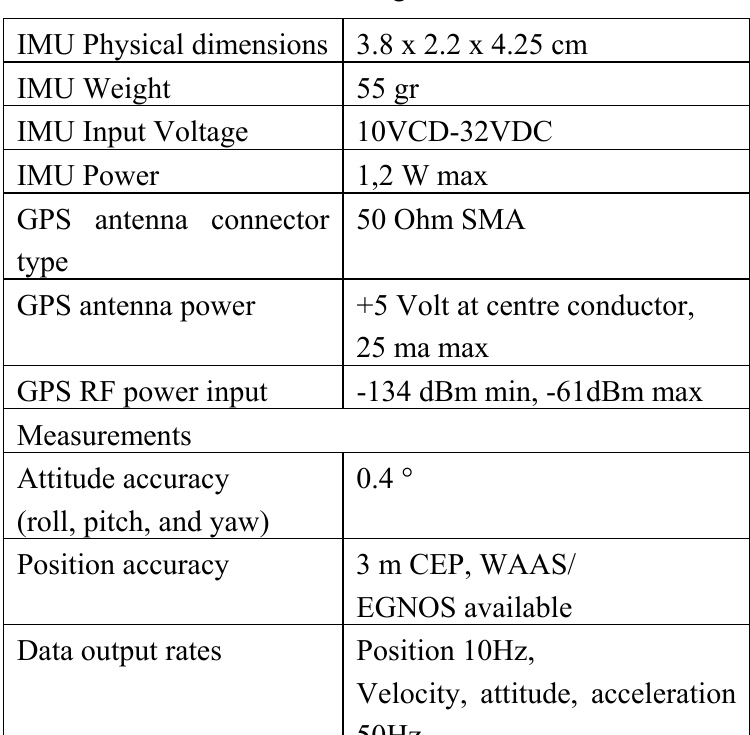
Table 3 . MIDG II Inertial Navigation Device